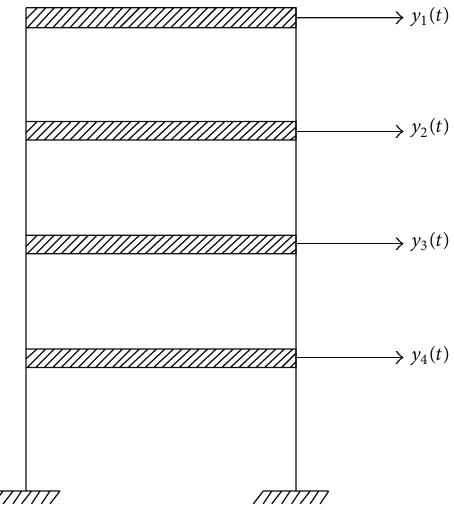
Figure 1: The four-story